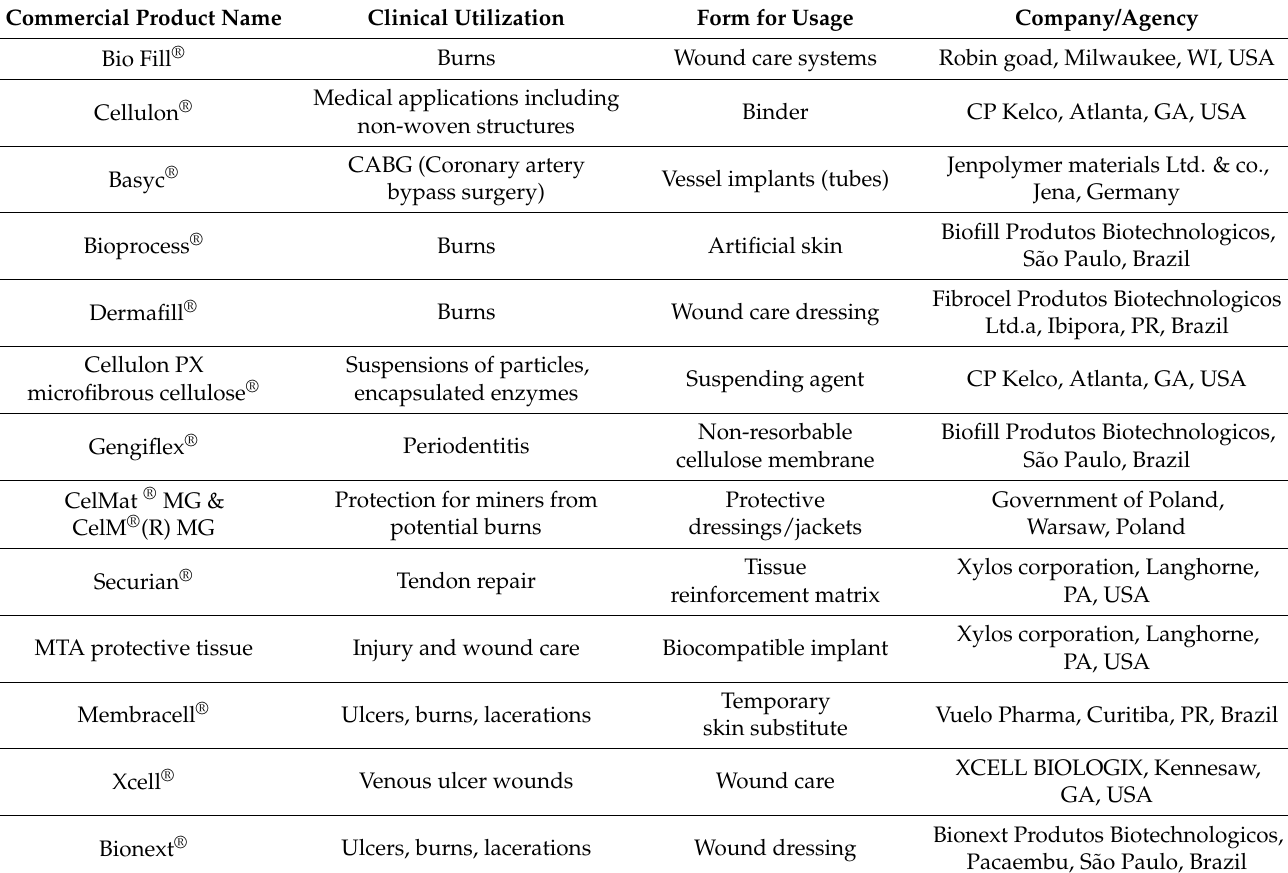
Table 1. Commercial bacterial cellulose products available on the market